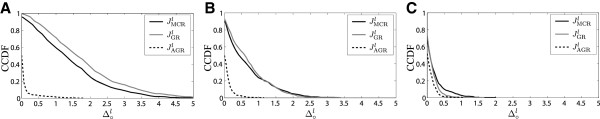
Empirical CCDF ofΔ∘l for different intervention policies across randomly generated PBNs with three genes.(A)κ=0.1. (B)κ=1.0. (C)κ=5.0.